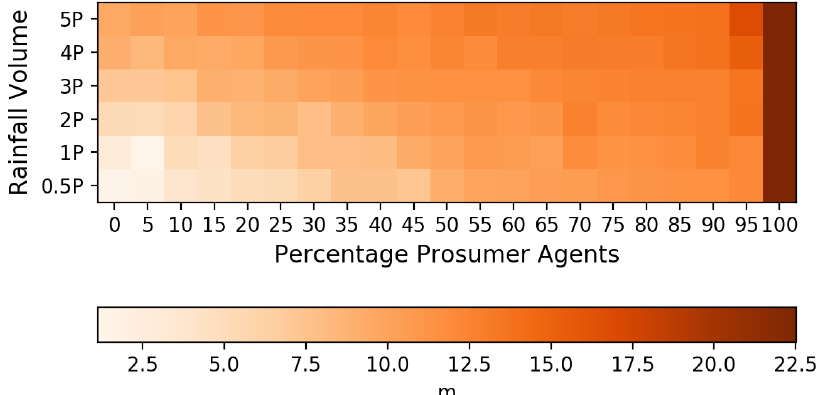
Figure 11. Minimum head (m) across consumer nodes for all scenarios.